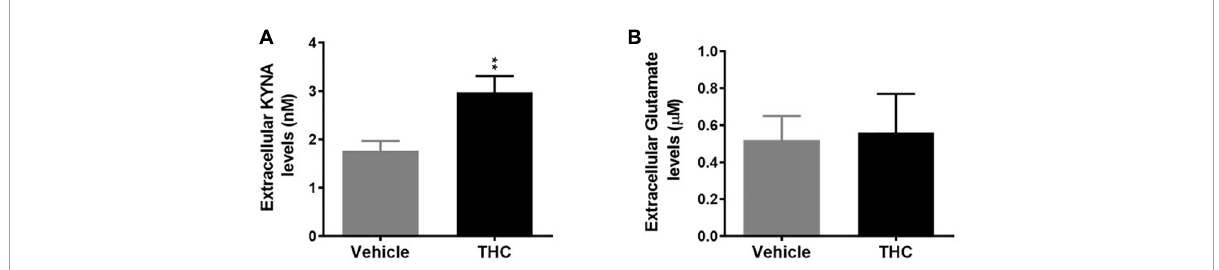
FIGURE4 Basal extracellular kynurenic acid (KYNA; panel A ) and glutamate (panel B ) levels in the medial prefrontal cortex of adult [post-natal day (PND) 75] male rats chronically exposed to delta 9-tetrahydrocannabinol (THC) or its vehicle (cremophor and saline 1:1:18; Vehicle) during the adolescent period. Ascending doses of THC or its vehicle were administered by i.p. to adolescent rats, from PD 35 to PD 45, wh. Data are the mean ± standard error of the mean (SEM); n = 5/6 male rats/group. ** p < 0.01 significantly different from the respective vehicle group based on Student’s t